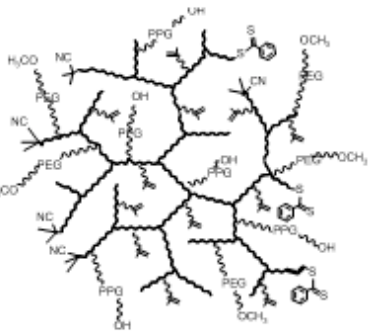
Figure 6. Schematic representation of the degradation PEGMEMA-PPGMA-DSDA polymer to primary chains by disulfide bond cleavage.